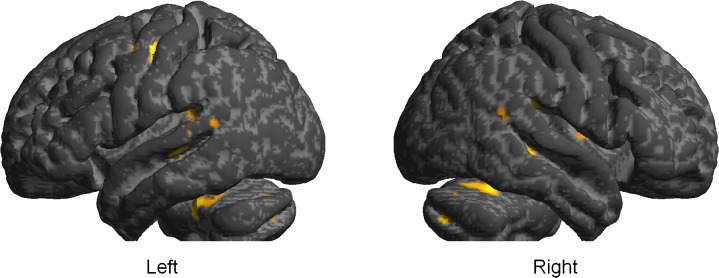
Effects of significantly attenuated neural semantic priming after hypnotic-suggestive treatment relative to normal wakefulness.The statistical parametric map reflecting the directed Treatment-by-Semantic Relatedness interaction t-contrast [(UnoT - RnoT) - (UTreat - RTreat)] was surface-rendered on the group averaged T1 image using SPM8.